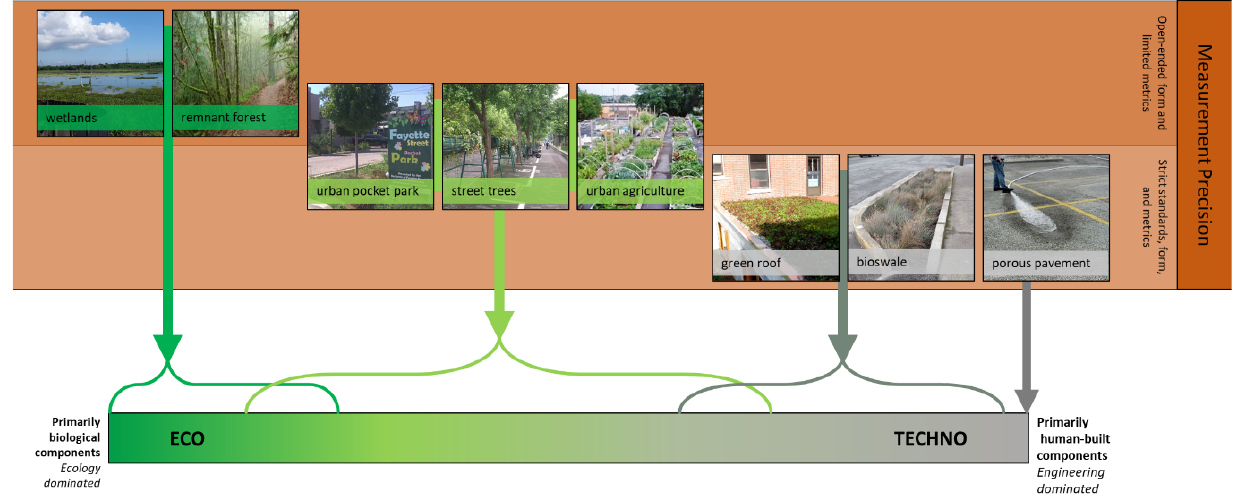
Figure 3. Precision and focus of metrics and standards vary across the eco-techno